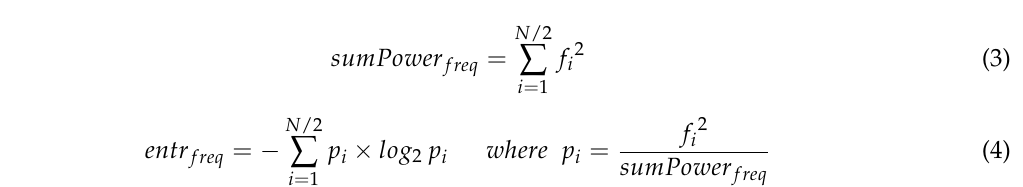
Figure 5. Features obtained in the frequency domain.